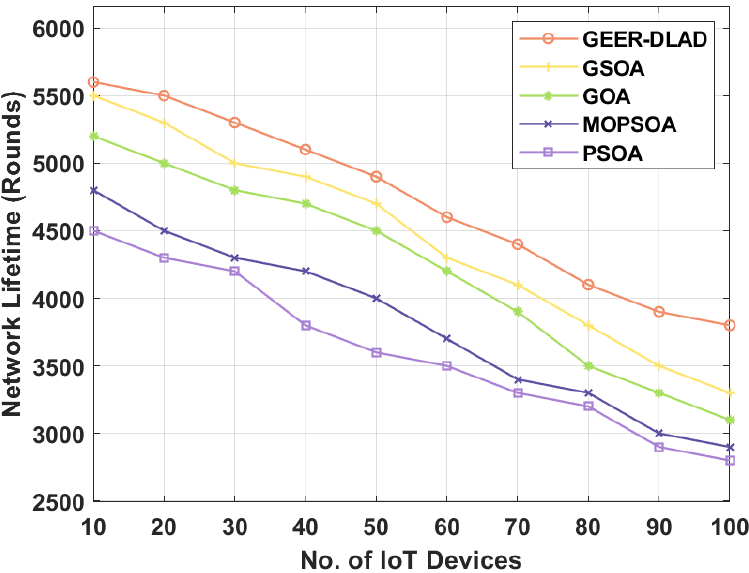
Figure 6. The Network lifetime analysis of GEER-DLAD model.